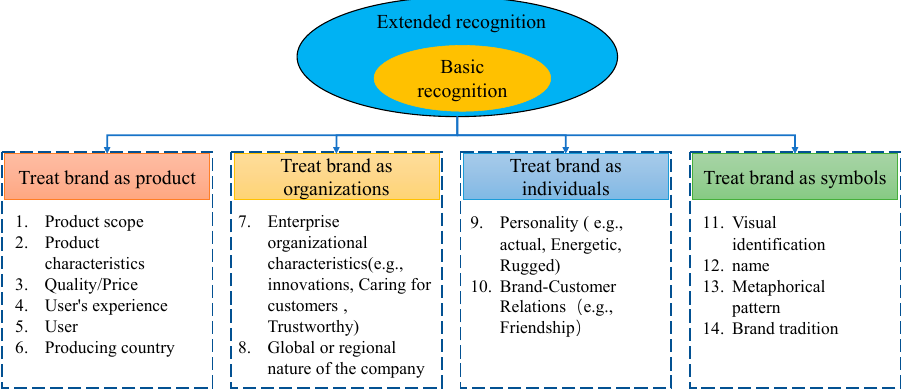
Figure 3. Brand Identity System depicted in Building Strong Brands.